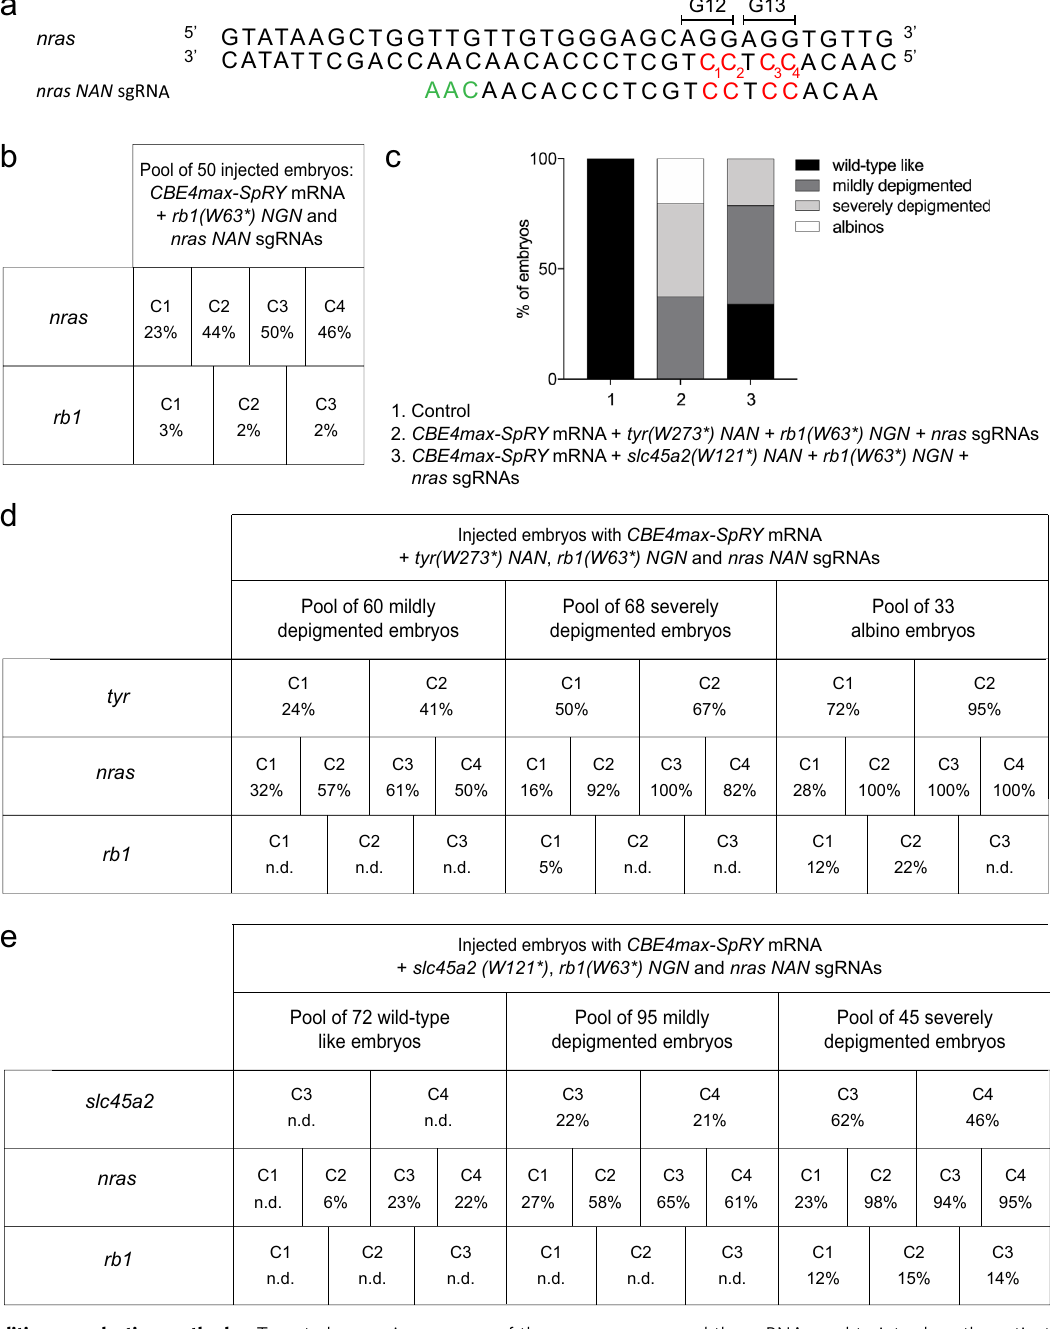
Fig. 3 Base editing co-selection method. a Targeted genomic sequence of the nras oncogene and the sgRNA used to introduce the activating mutation. The targeted Cs are in red and the PAM sequence is in green. b C-to-T conversion ef fi ciency for each targeted Cs in nras and rb1 genes in a pool of 50 embryos injected with CBE4max-SpRY mRNA and nras NAN and rb1 ( W63*) NGN sgRNAs. The ef fi ciencies have been calculated using EditR tool 42 and chromatograms from Sanger sequencing of PCR products. c Proportion of the 4 groups based on the pigmentation defects described in Fig. 1c for the embryos injected with the CBE4max-SpRY mRNA, the tyr(W273*)NAN, nras NAA and rb1(W63*)NGN sgRNAs (column 2, 161 embryos in total) and with the CBE4max-SpRY mRNA, the slc45a2(W121*), nras NAA and rb1(W63*)NGN sgRNAs (column 3, 212 embryos in total). d , e C-to-T conversion ef fi ciency for each targeted Cs and each pool of embryos showing pigmentation defects presented in Fig. 1b for the tyrosinase , nras , and rb1 genes ( d ) and the slc45a2 , nras , and rb1 genes ( e ). The albino embryos are the most edited for the three different loci. The ef fi ciencies have been calculated using EditR tool 42 and chromatograms from Sanger sequencing of PCR products. N.d. = no base editing detected using EditR